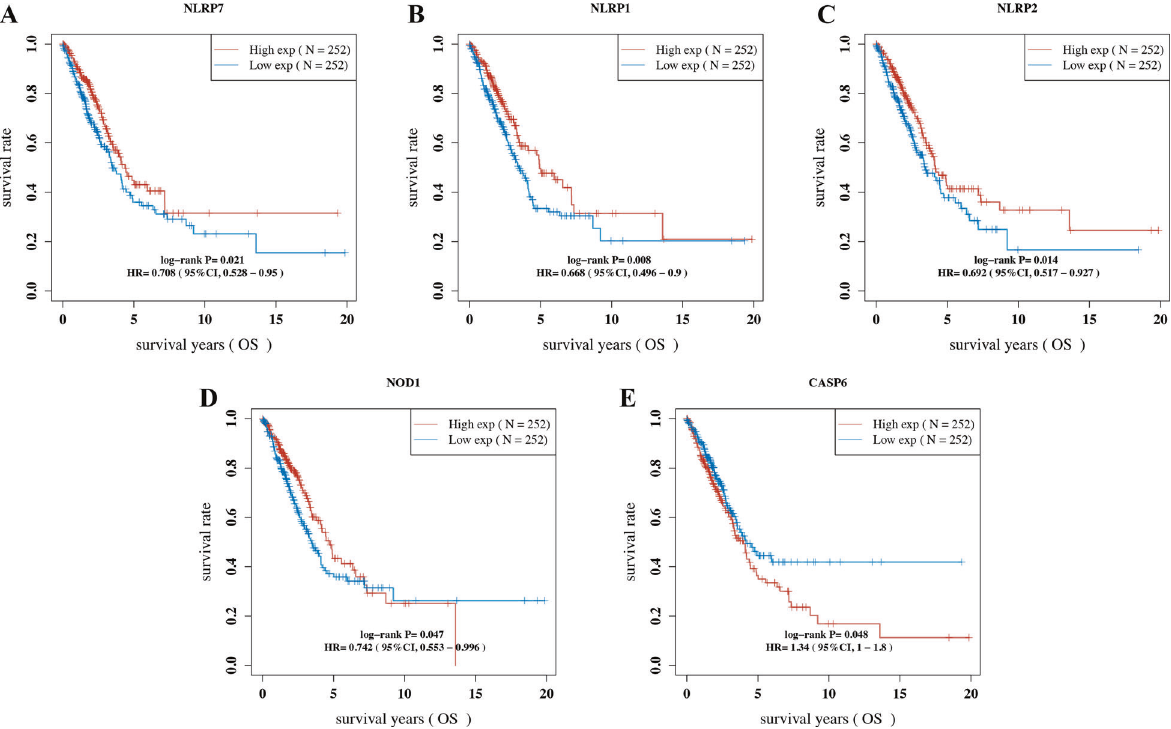
Fig. 3 The prognostic value of PRG in LUAD. The overall survival curve of NLRP7 A NLRP1 B NLRP2 C NOD1 D and CASP6 E in LUAD patients in the high-/low-expression group. PRG pyroptosis ‑ related gene, LUAD lung